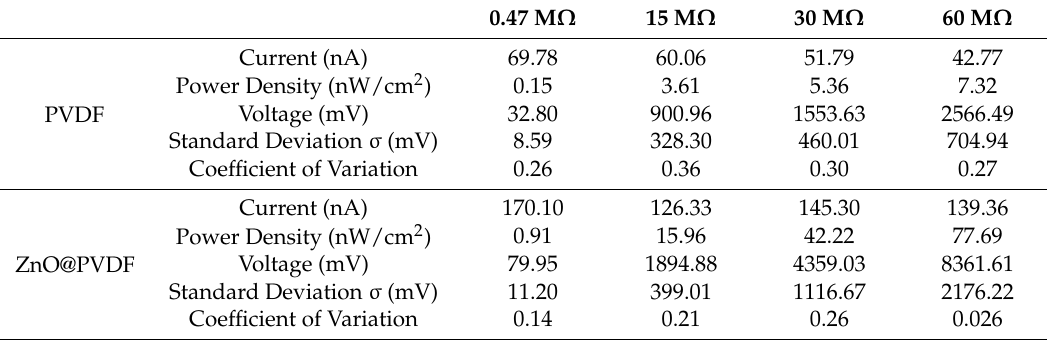
Table 2. Measured closed-circuit current and voltage averages with conductive knitted fabric